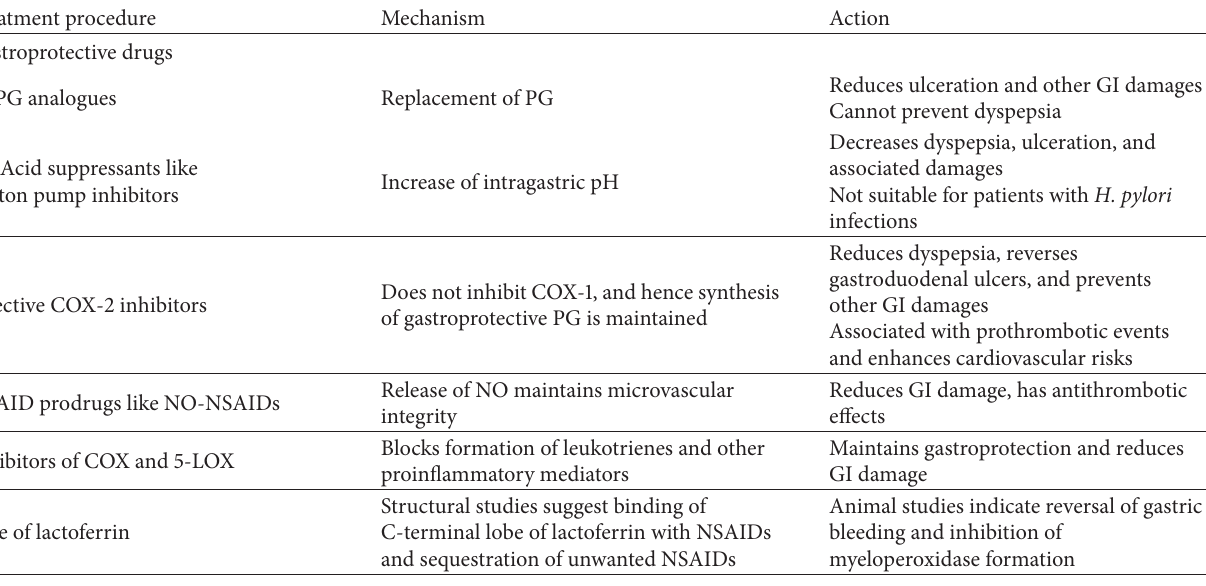
Table 2: . Strategies to prevent NSAID-induced gastrointestinal